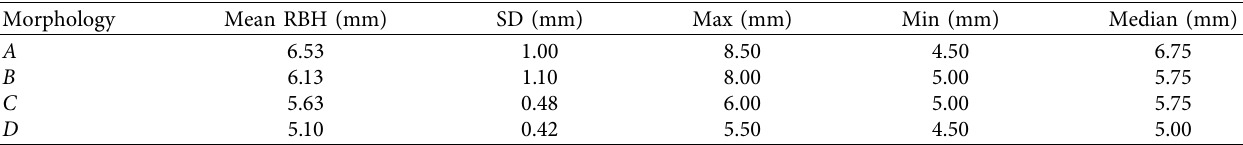
Table 3: The RBH values are compared between of different morphological classifications based on the sagittal plane. Morphology